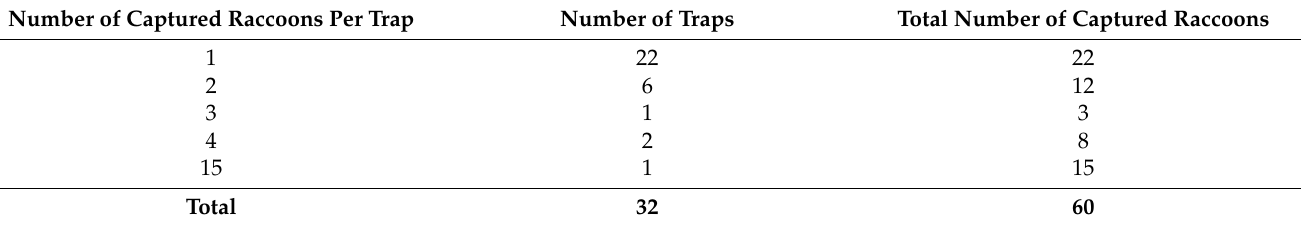
Figure 2. Raccoon - trapping sites (the proximity of some trapping sites results in the overlapping of dots in the picture). The red areas represent the raccoon “core zone”.